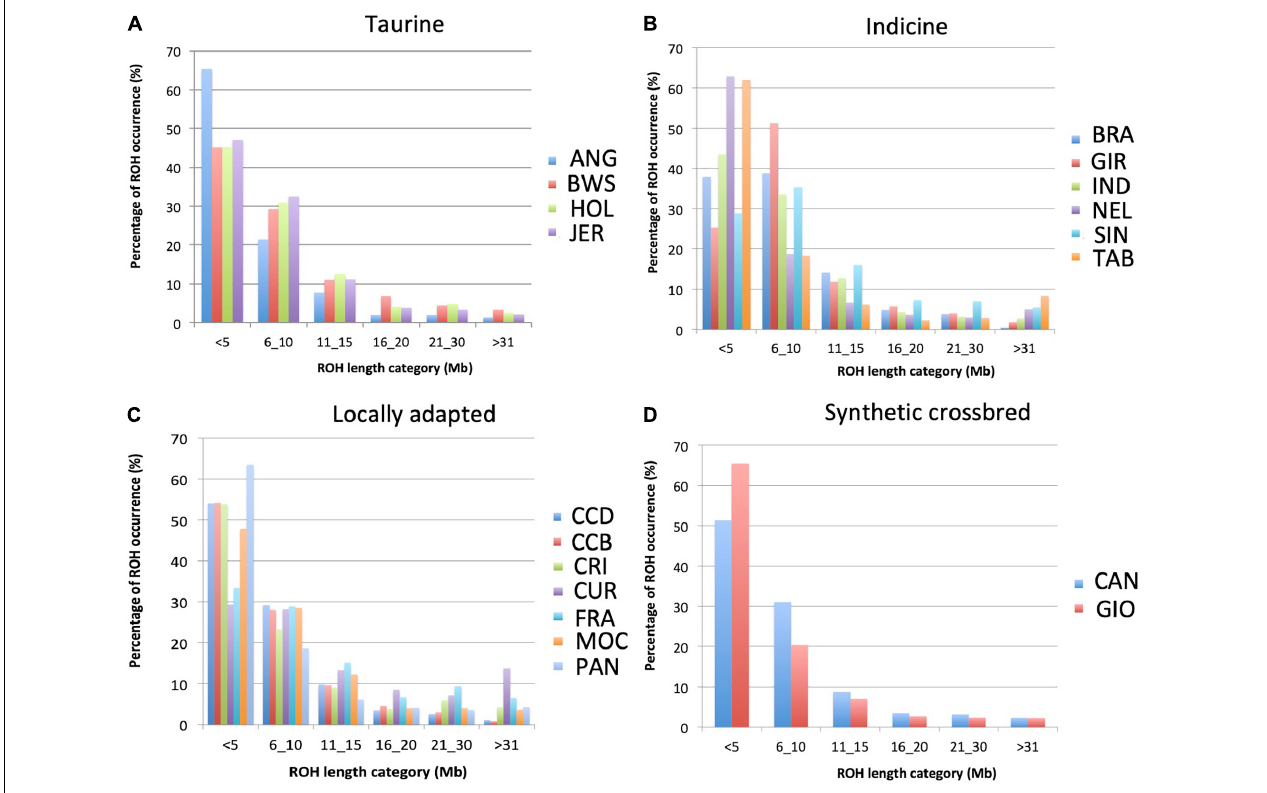
FIGURE 4 | Percentage of runs of homozygosity (ROH) per length categories in 19 cattle breeds raised in Brazil. The sum of ROH was calculated per animal within each ROH length category for 19 breeds separated into (A) taurine, (B) indicine, (C) locally adapted, and (D) synthetic crossbreds groups. ANG, Angus; BWS, Brown Swiss; JER, Jersey; HOL, Holstein; BRA, Brahman; GIR, Gir; IND, Indubrasil; NEL, Nelore; SIN, Sindhi; TAB, Tabapuã; CCD, Caracu dairy; CCBO, Caracu beef; CRI, CriouloLageano; CUR, CurraleiroPé-Duro; FRA, CriouloLageano do RS; MOC, MochoNacional; PAN, Pantaneiro; CAN, Canchim; GIO,